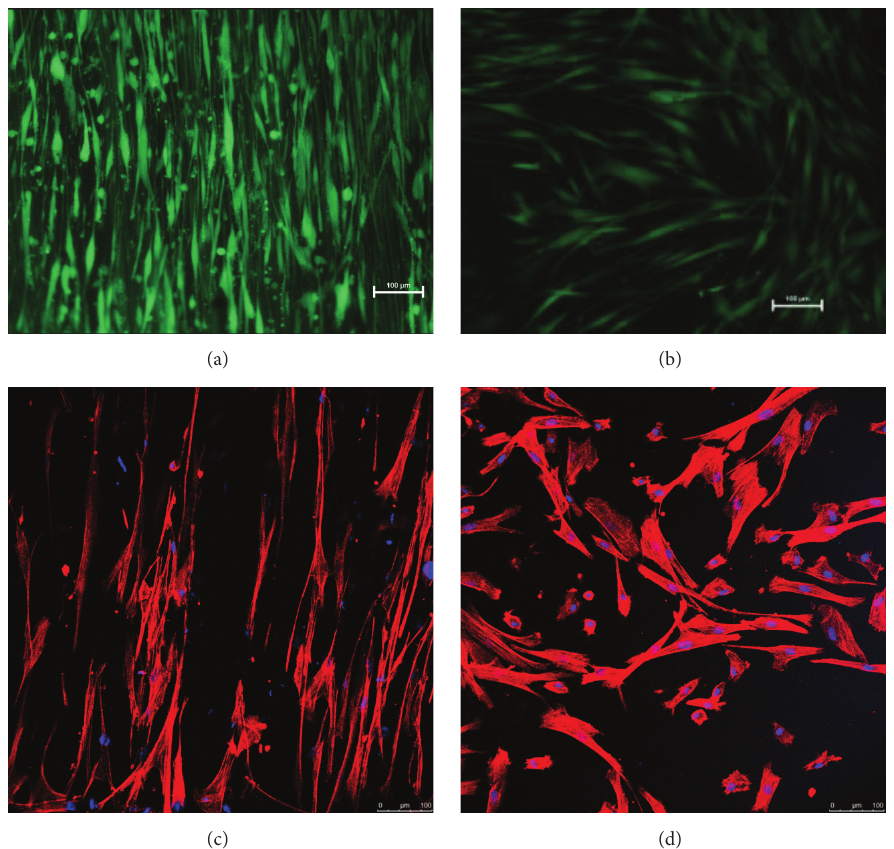
Figure 3: Fibroblasts cultures on aligned fiber (a) and on tissue culture plastic (b) for 14 days; cells are stained with calcein AM. SMCs orientated on melt spun aligned fiber (c) and cultured on chitosan film (d) for several days. The cells are immunostained for F-actin and DAPI nuclear